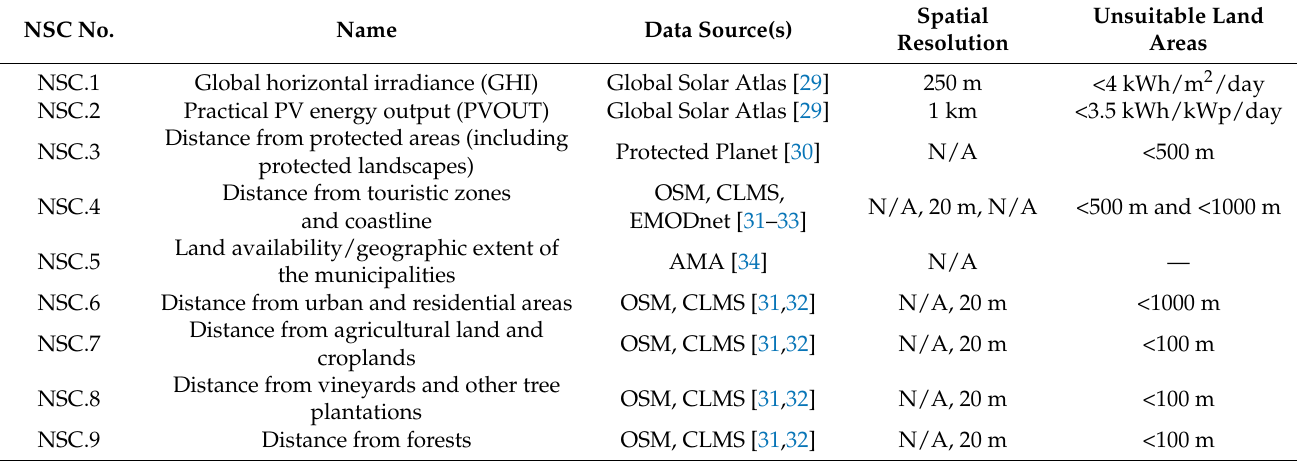
Table 1. NSC and data sources employed in Phase 1 of the proposed framework. Note 1: OSM, Open- StreetMap, OSM; CLMS, Copernicus Land Monitoring Service; AMA, Ag ê ncia para a Modernizaç ã o Administrativa. Note 2: The minimum mapping unit (MMU) of Corine land cover data provided by CLMS is 25